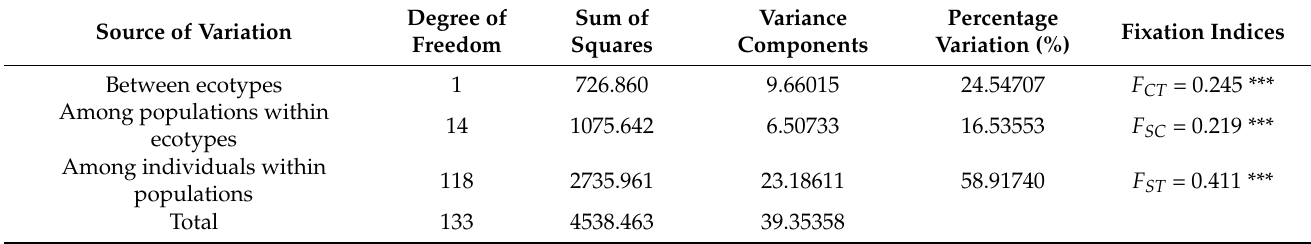
Table 4. The proportion of genetic variance partitioned between ecotypes, among populations within ecotypes, and among individuals within populations as determined by analysis of molecular variance (AMOVA).